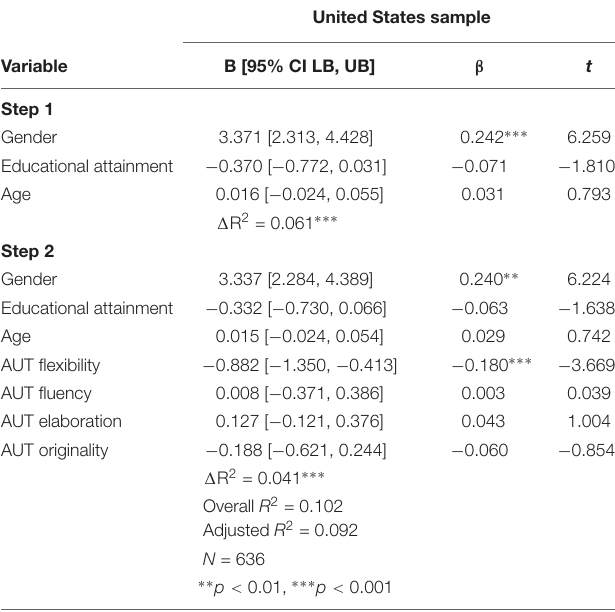
TABLE 2 | Explaining willingness to fight for the group with performance on the alternative uses task